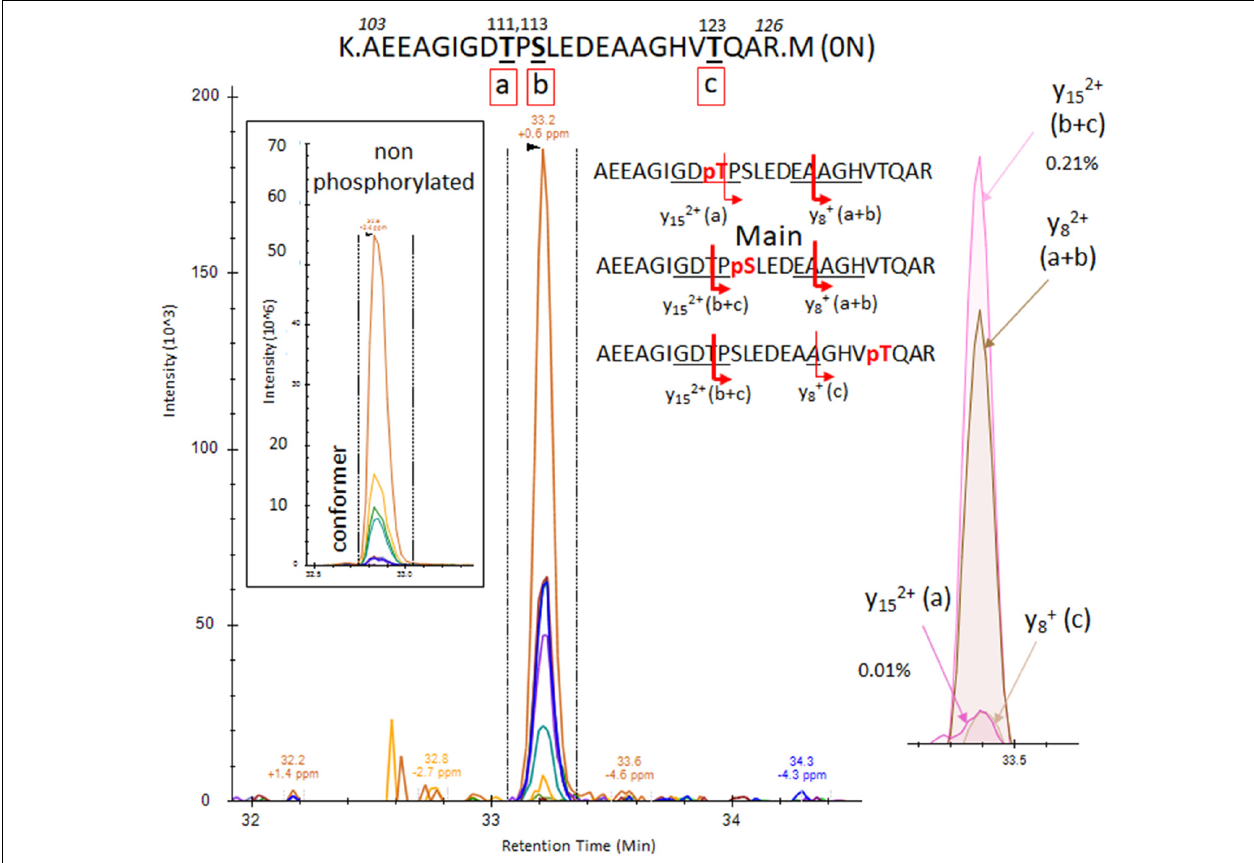
FIGURE 2 | PRM screening of the mono-phosphorylated tau (p-tau) sequence at 103–126 (0N isoform). We identified a unique LC-mass spectrometry (MS)/MS pattern eluting closely to the unmodified peptide 103–126 and containing fragment series expected for phosphorylation at T111 (a), S113 (b) or T123 (c). Hypothetical y ion fragments from each p-tau peptide are underlined on the sequences. We deconvoluted the potential co-elution of the three putative mono-phosphorylated peptides. Ion fragment y15 without phosphate is specific to the phosphorylated peptide on residue T111 [y15 (a)] and the y8 fragment with phosphate is specific to p-tau peptide on residue T123 [y8 (c)]. Corresponding extracted ion chromatograms (XIC) are detected in low abundance above the limit of detection, supporting the identification of the two corresponding mono-p-tau peptides. In contrast, the y15 fragment with phosphate, shared by pT111 and pS113 [y15 (a+b)], and the y8 fragment without phosphate, shared by pS113 and pT123 [y8 (b+c)], are much more abundant. These signal differences support the existence of the tau peptide mono-phosphorylated at residue S113 (b) as the main component of the